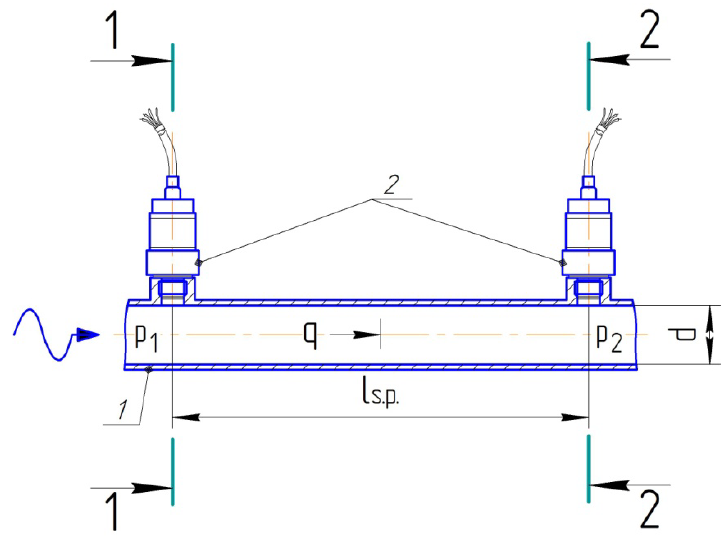
Figure 7. The “short” pipeline diagram of R.N. Starobinskiy (1—measuring pipeline, 2—dynamic pressure sensors).